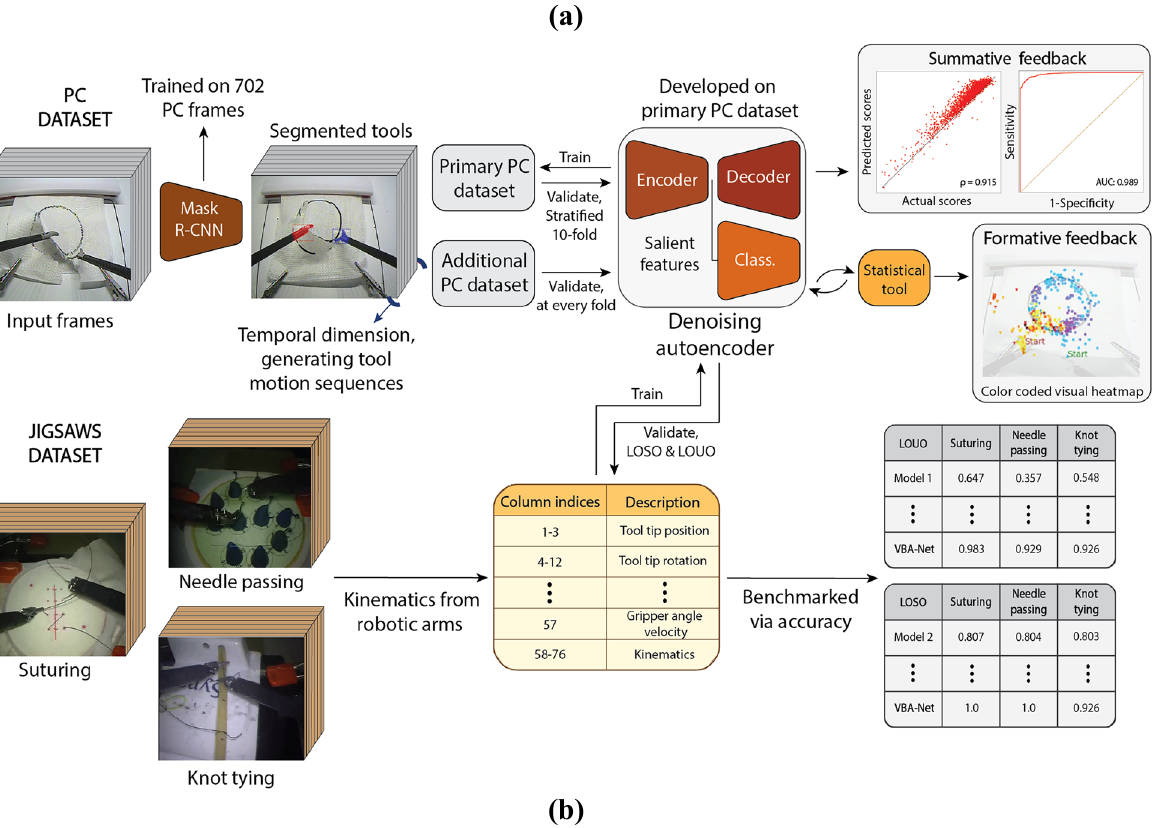
Figure 1. Overview of the study. (a) Subject demographics and descriptive data. (b) The pipeline of the VBA- Net. The model utilizes Mask R-CNN to generate tool motion sequences from video frames. Then